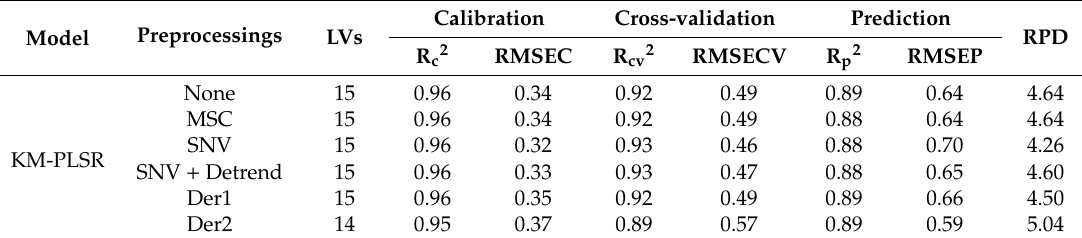
1 versus PC 2 based on A spectral